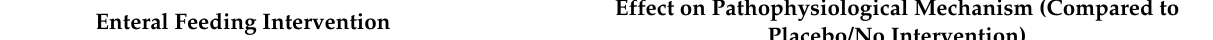
Table 15. Effect of enteral feeding interventions that affect pathophysiological mechanisms of NEC in human studies. Effect on Pathophysiological Mechanism (Compared Enteral Feeding Intervention